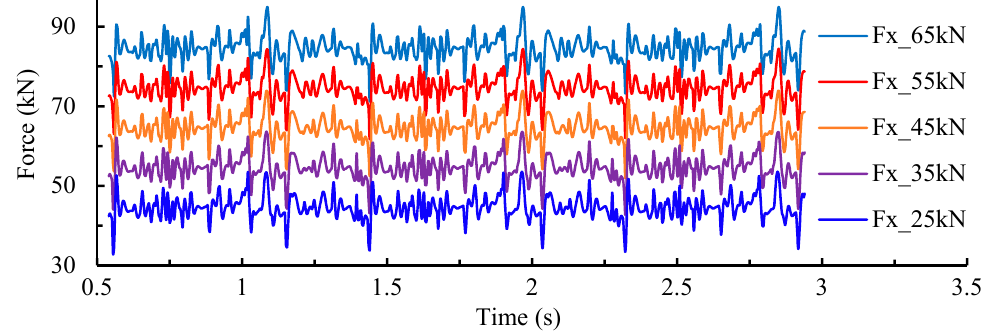
Figure 6. The x-direction force of the walking wheel under different forward resistance force.